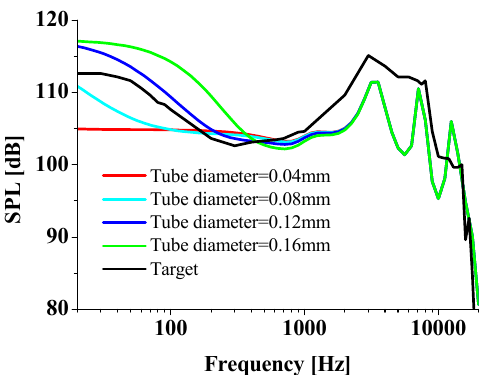
Figure 17. Acoustic tube diameter influence and target SPL (simulation result).